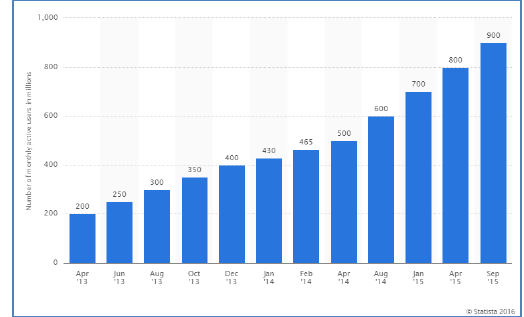
Figure 1: Number of monthly active WhatsApp users worldwide from April 2013 to September 2015 (in millions) Source: (Statista,